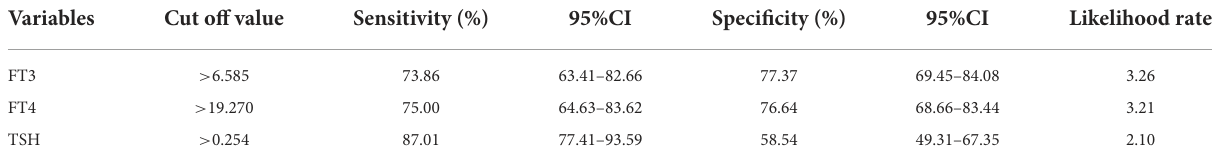
TABLE 5 Cut of values of FT3, FT4, and TSH.